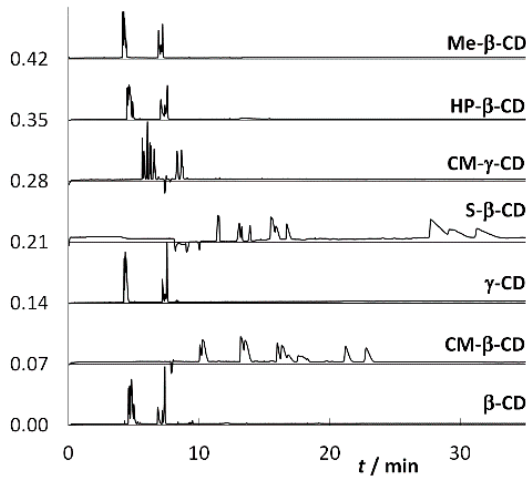
Figure 3. Electropherograms of the analyzed mixture of the studied analytes 1–9 (Figure 2) obtained at different CDs used; fused-silica capillary: od/id = 375/75 μ m, total/effective length: 58.5/50.0 cm; BGE: 50 mmol · L − 1 phosphate bu ff er, pH 2.5, 10 mmol · L − 1 CD; voltage: 20 kV ( − 20 kV for S- β -CD); temperature: 25 ◦ C.